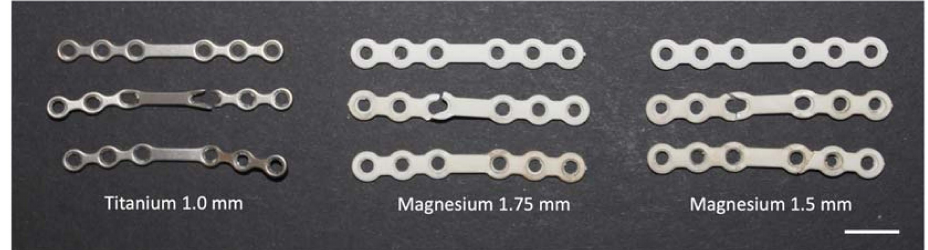
Figure 5. Exemplary plate deformation of the tested plates compared to an original plate (top row). Examples show test samples of the upper plate (middle row) and lower plate (bottom row), with the side facing the mandibular angle facing to the